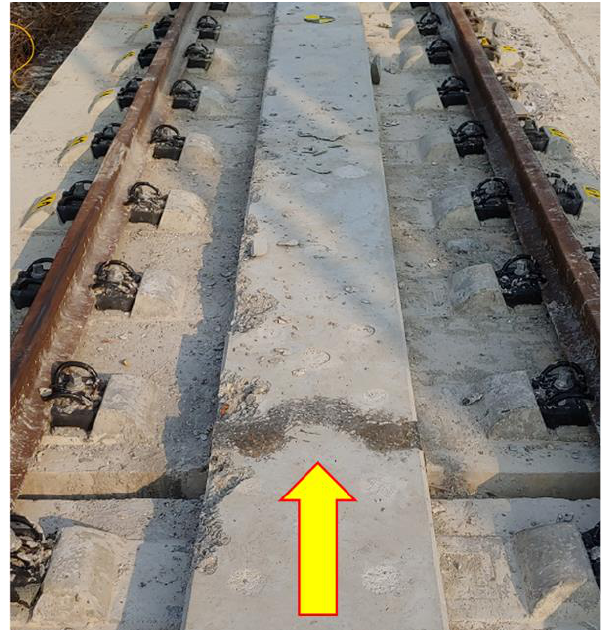
Figure 16. Damage status of DCP after collision.